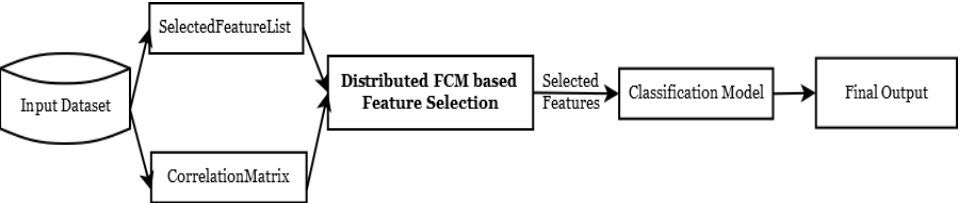
Figure 1. Proposed model workflow